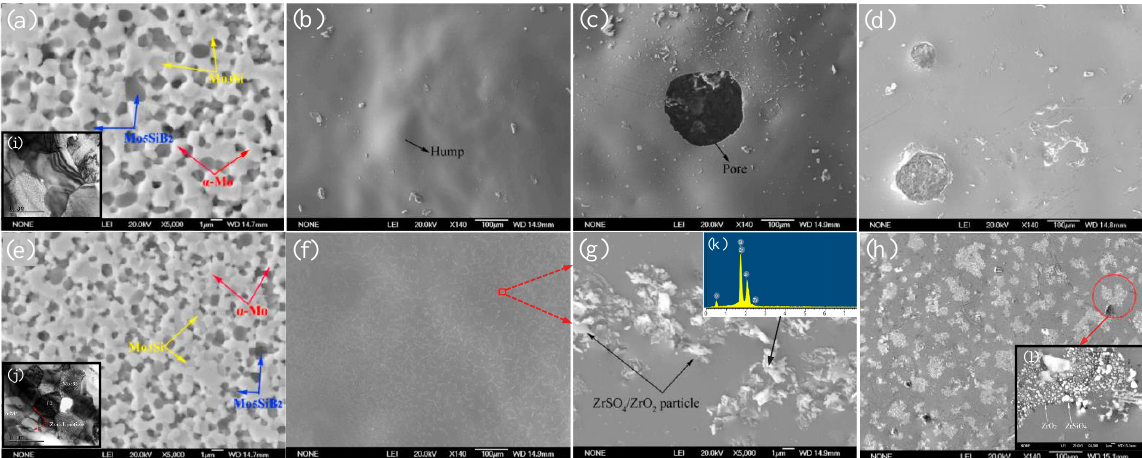
Figure 8. SEM micrographs: ( a ) MSB, ( e ) MSBZ with ( i , j ) TEM micrographs; Surfaces of SEM micrographs of the MSB alloy and MSBZ alloy oxidized for 30 h at: ( b , c , f , g ) 900 °C and ( d , h ) 1300 °C; ( k ) EDS pattern of the bright granules in ( g ); ( l ) local magnification image. ( a – c , e – g , k , d , h – j , l ) reproduced with permission [53,54], respectively. Copyright 2017 Else- vier.